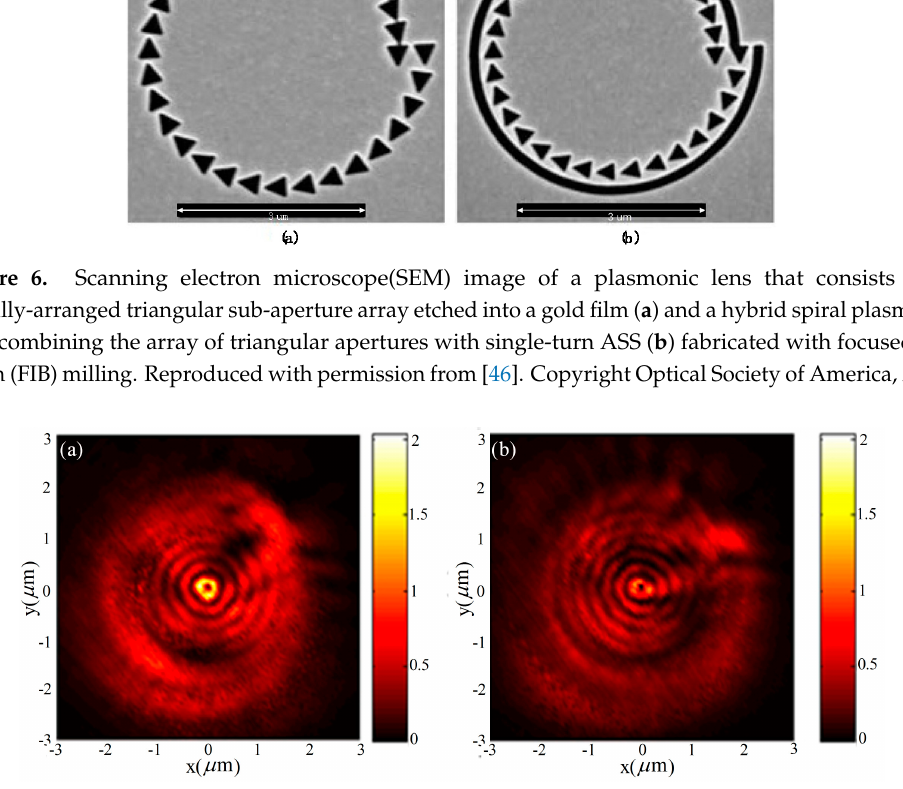
Figure 7. Measured NSOM near-field intensity distribution images of the left-handed arranged spiral triangular aperture array under ( a ) RCP and ( b ) LCP incidence. Reproduced with permission from [46]. Copyright Optical Society of America, 2012.